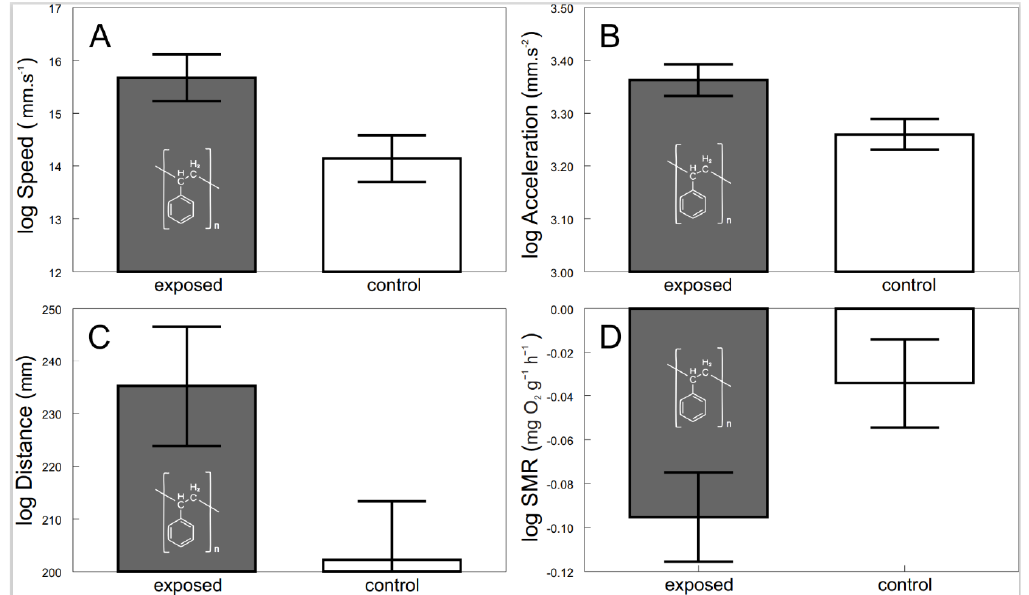
Figure 2. Speed ( A ), acceleration ( B ), distance ( C ) and standard metabolic rate ( D ) of exposed (grey bars with polystyrene formula) and control (white bars) shrimps. Values are adjusted means (+/−S.E.).